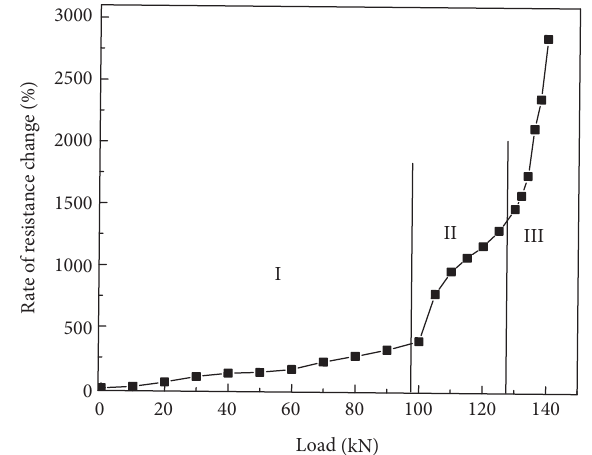
Figure 14: Resistance change rate-load